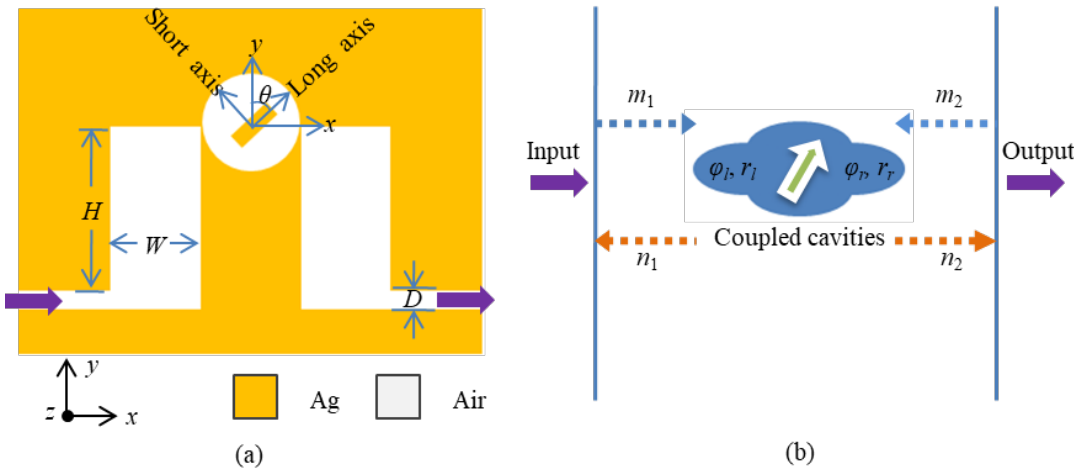
Figure 1. ( a ) The schematic diagram of a coupled-waveguide-cavity structure comprising a metal-core circular cavity, two side-coupled rectangular cavities, and MIM plasmonic waveguides at the input and output ports; and ( b ) its simplified transfer-matrix-theory model.